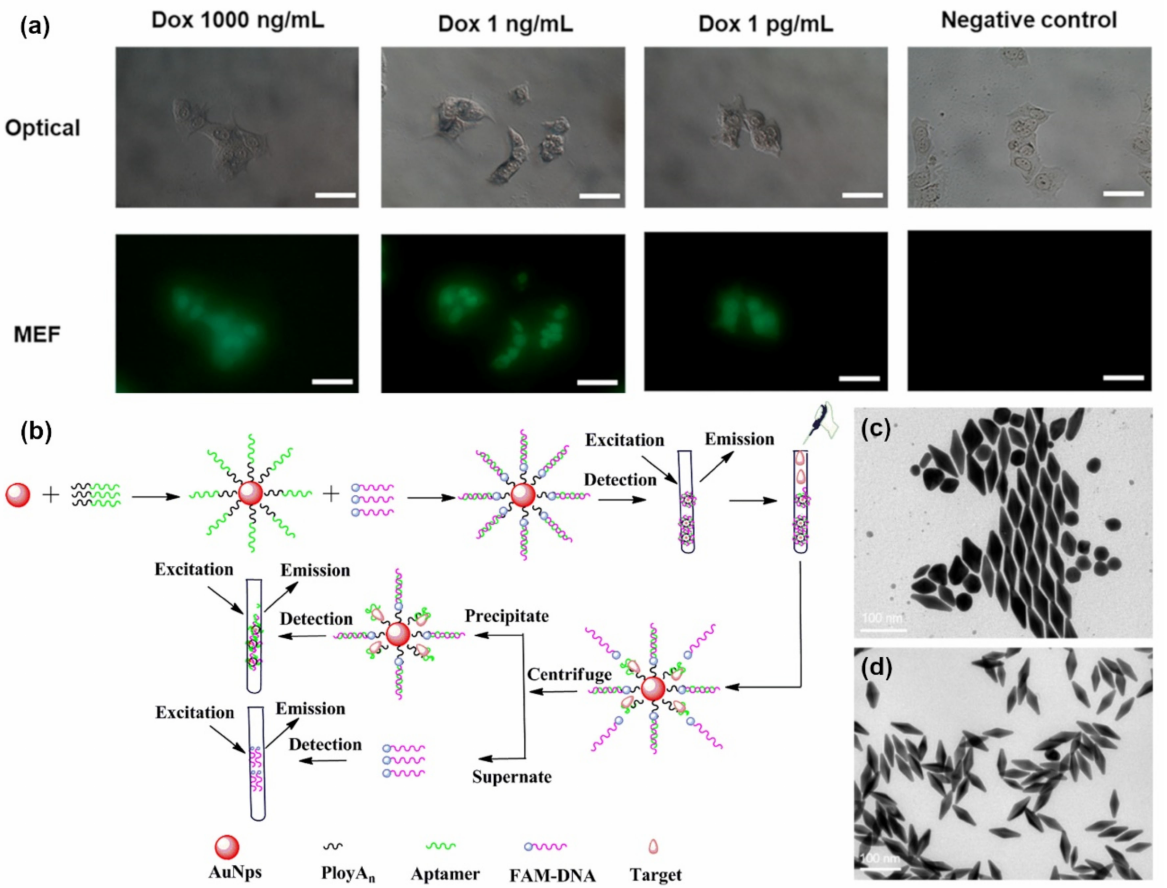
Figure 4. Metal-enhanced fluorescence biosensors: ( a ) Fluorescence imaging of Dox-treated MCF- 7 cells. (Scale bars are 100 µ m) ( b ) AuNPs@polyAn-aptamer@FAM-DNA nanostructure for ATP detection. ( c ) TEM image of synthetized AuNBPs with LPRW at 751 nm before separation. ( d ) TEM image of AuNBPs with LPRW at 751 nm after separation. (Reproduced with permission from [81], published by American Chemical Society 2020; reproduced with permission from [81], published by Elsevier 2019; reproduced with permission from [83], published by Elsevier